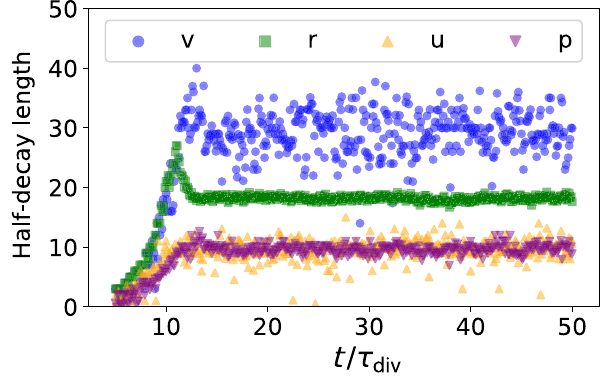
¼ τ ¼ 5 τ . The mean r v div and all results in the main text are div